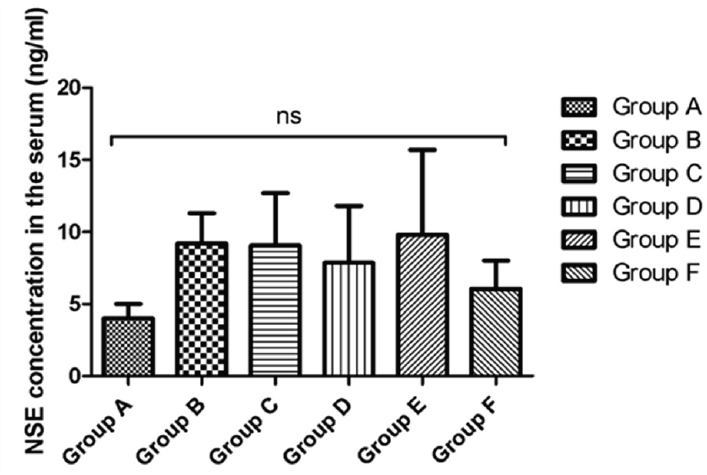
Figure 7. Serum neuron specific enolase (NSE) concentrations (ng/mL) in the different experimental groups on day 21 of the experiment. “ns” indicates not-significant.